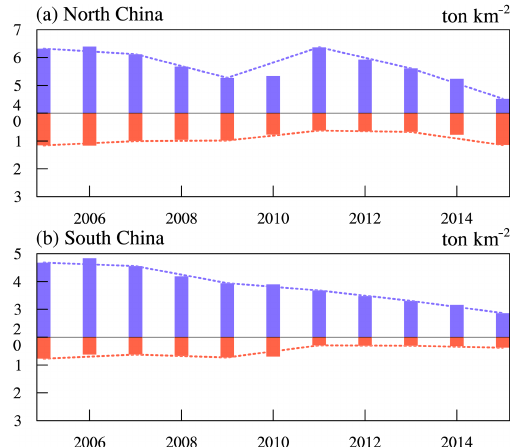
Figure 11. Annual SO 2 emission (tkm − 2 ) generated by industries (upward blue bars) and households (downward red bars) in North China (a) and South China (b) . Note that the y axis in a positive direction does not start at